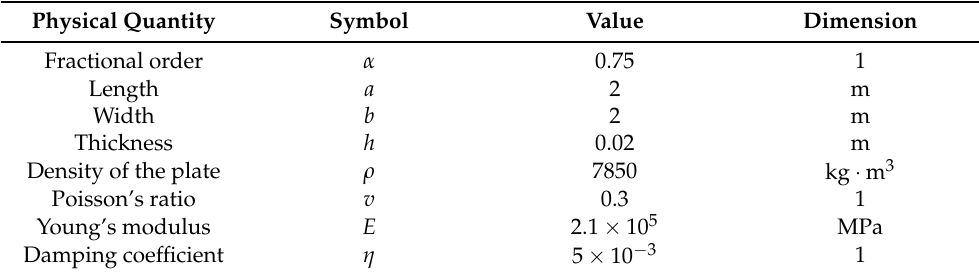
Table 1. Geometric properties of viscoelastic plate materials